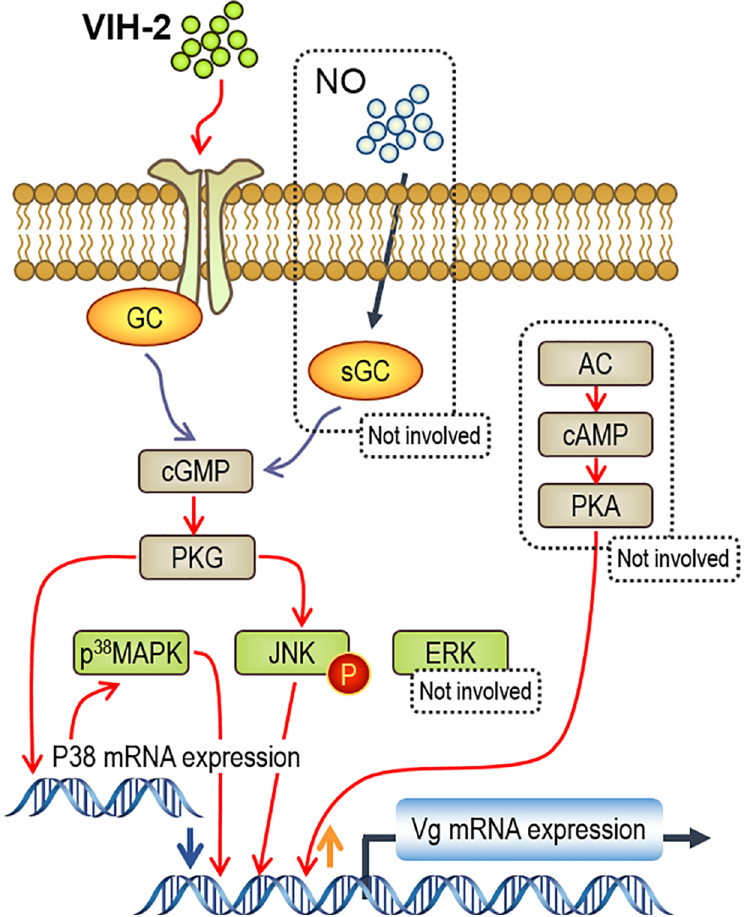
Fig 8. Working model for the signal transduction mechanism of VIH-2 suppressed Vg mRNA expression in the shrimp hepatopancreas. In this case, a membrane receptor GC activation by VIH-2 can generate cGMP and subsequently activate PKG. The downstream MAPK-dependent cascades are then activated by cooperation of JNK phosphorylation and P 38 MAPK content increase, to inhibit the gene expression of Vg in the hepatopancreas of L . vannamei